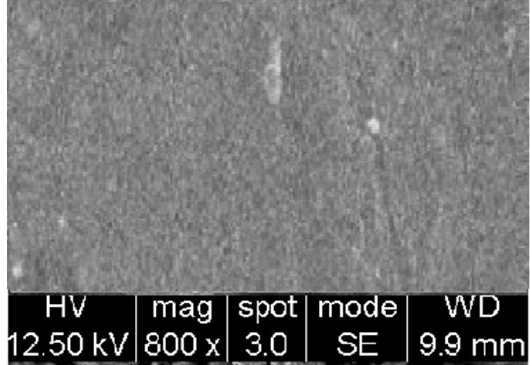
Figure 13. Surface of the material before AWJM.